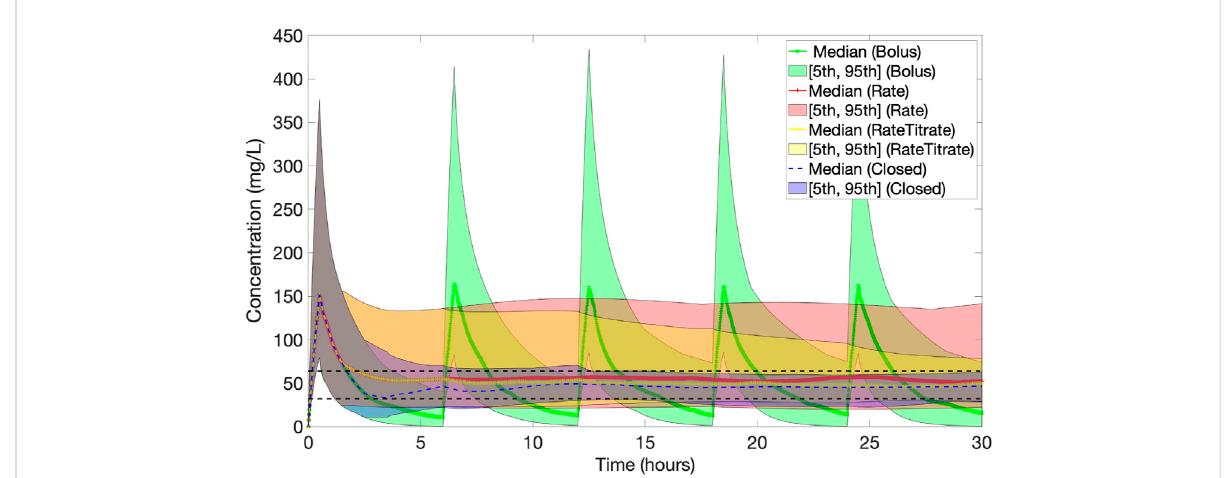
FIGURE 7 Population results [Median (5, 95)%] of piperacillin concentration (mg/L) over time corresponding to dosing by the PID controller (Closed) (in blue) together with the results for baseline protocols 1 (Bolus) (in green), 2 (Rate) (in red) and 3 (Rate Titrated) (in yellow). The black dashed lines indicate the 32 – 64 mg/L evaluation range. The PID controller reduces the population variability the most.